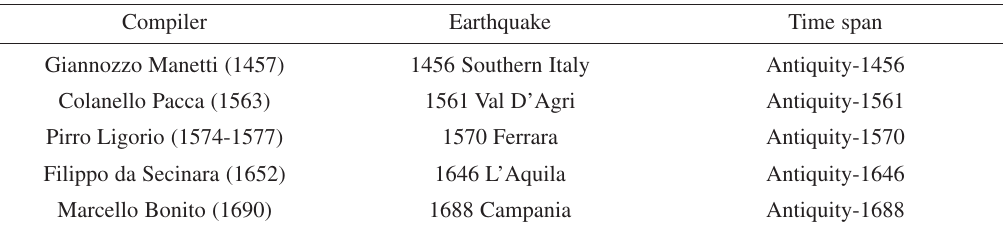
Table I. Main Italian compilers of earthquake lists in the 16th and 17th